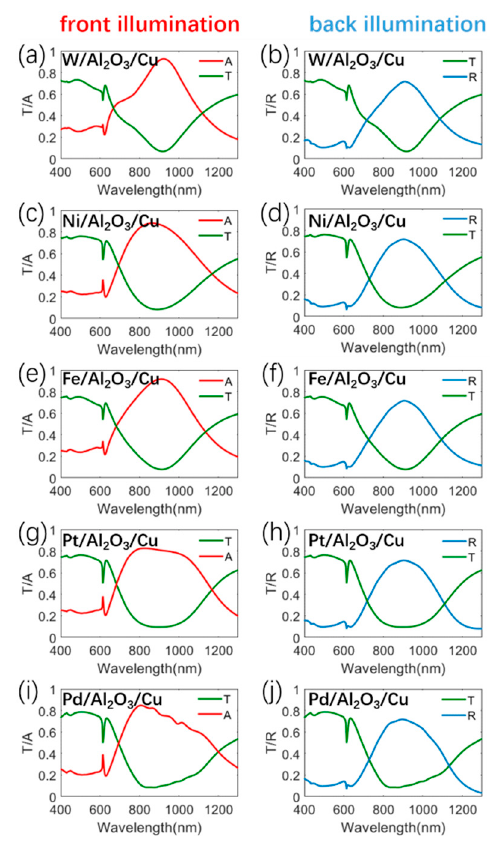
Figure 7. Simulation optical responses of the metasurface consisting of W / Al 2 O 3 / Cu structures for ( a ) front illumination and ( b ) back illumination. Simulation optical responses of the metasurface consisting of Ni/Al 2 O 3 /Cu structures for ( c ) front illumination and ( d ) back illumination. Simulation optical responses of the metasurface consisting of Fe/Al 2 O 3 /Cu structures for ( e ) front illumination and ( f ) back illumination. Simulation optical responses of the metasurface consisting of Pt/Al 2 O 3 /Cu structures for ( g ) front illumination and ( h ) back illumination. Simulation optical responses of the metasurface consisting of Pd/Al 2 O 3 /Cu structures for ( i ) front illumination and ( j ) back illumination.